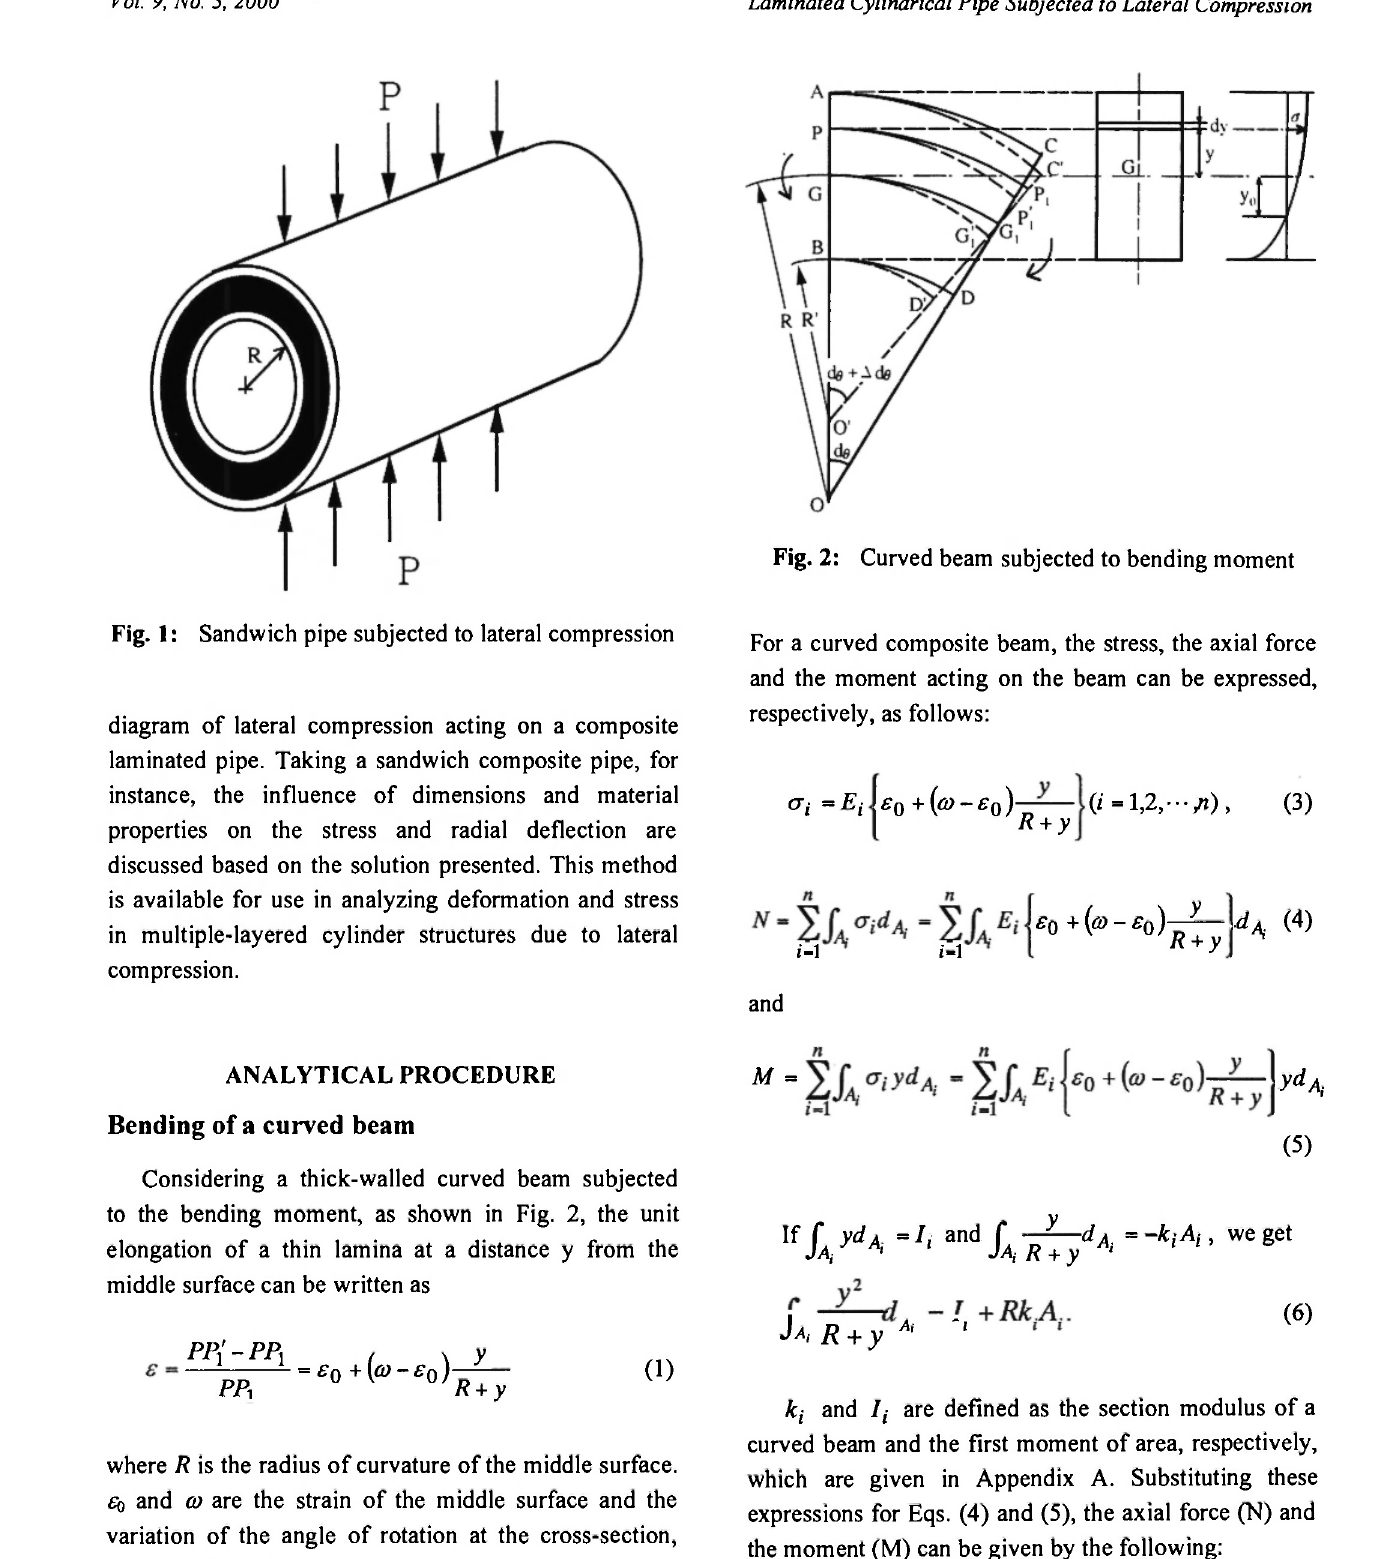
Fig. 2: Curved beam subjected to bending